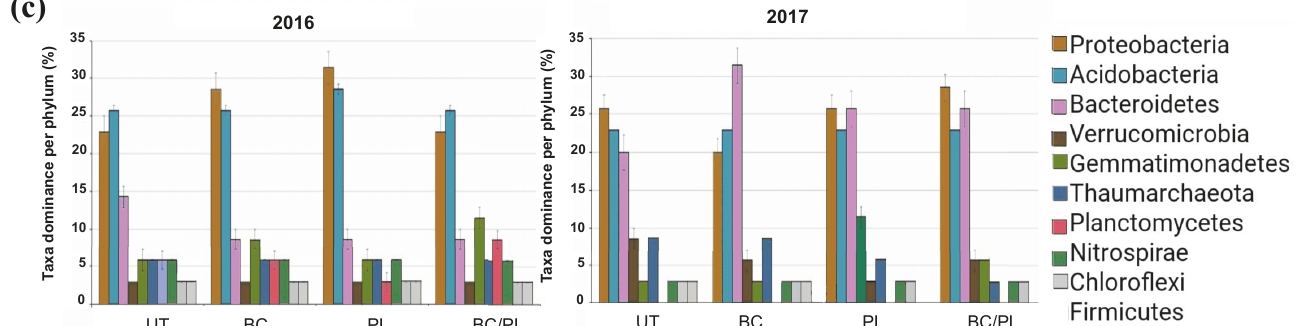
Figure 5. Microbial interaction networks of dominant taxa at the genus level (top 35) in the bulk soil in ( a ) 2016 and ( b ) 2017 for untreated (UT) soil and soils treated with biochar (BC), poultry litter (PL), and a combination of biochar and poultry litter (BC/PL). The size of the nodes shows taxa abundance, and the different colors indicate the corresponding taxonomic assignment at the phylum level. The edge color represents positive (green) and negative (pink) correlations. The edge thickness indicates the correlation values; only significant interactions are shown (r > 0.6; p < 0.01). ( c ) Taxa dominance (Top 10) in the microbial network per